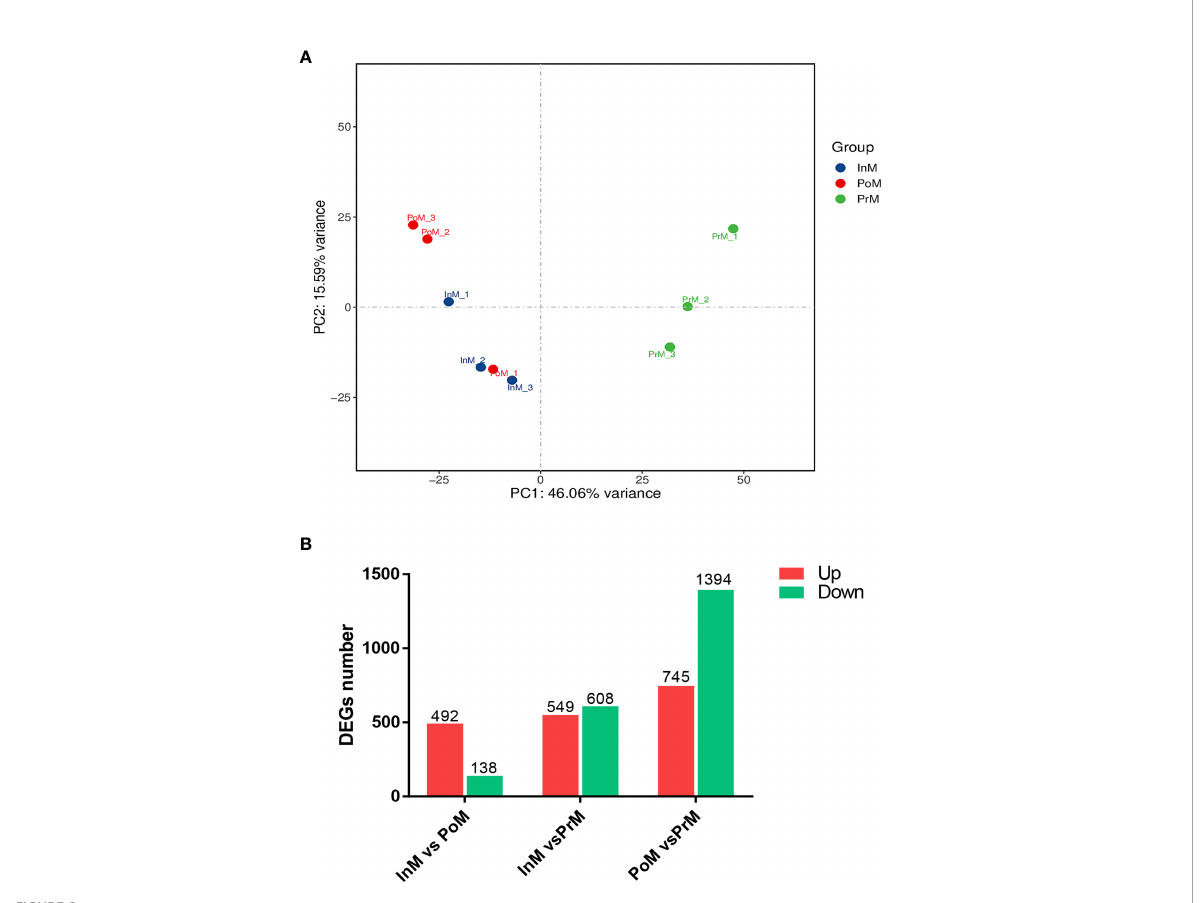
FIGURE 2 mRNA expression overview of molt stages of S. paramamosain . (A) PCA analysis between adjacent molting stages in S. paramamosain . (B) Differentially expressed genes between adjacent molting stages in S. paramamosain . The values in red and green indicate the numbers of upregulated and downregulated mRNA. PoM, postmolt; InM, intermolt; PrM,